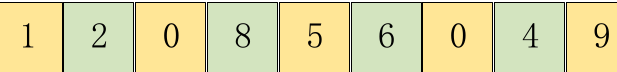
Figure 2. Chromosome encoding and example.